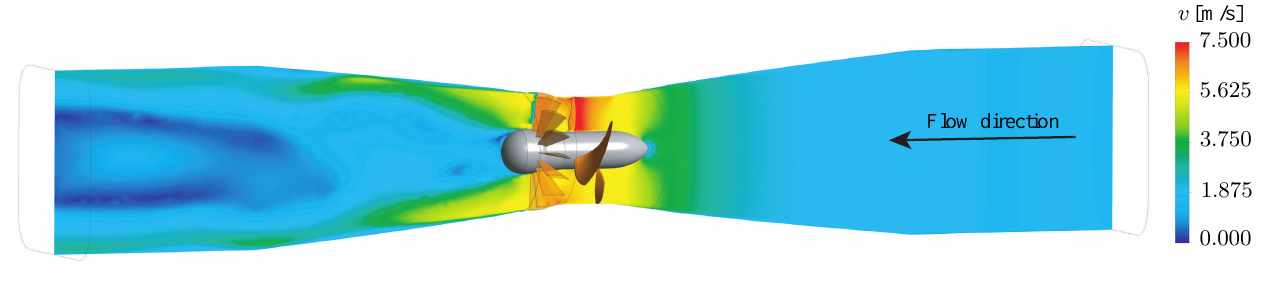
Fig. 13. Velocity distribution in pumping mode